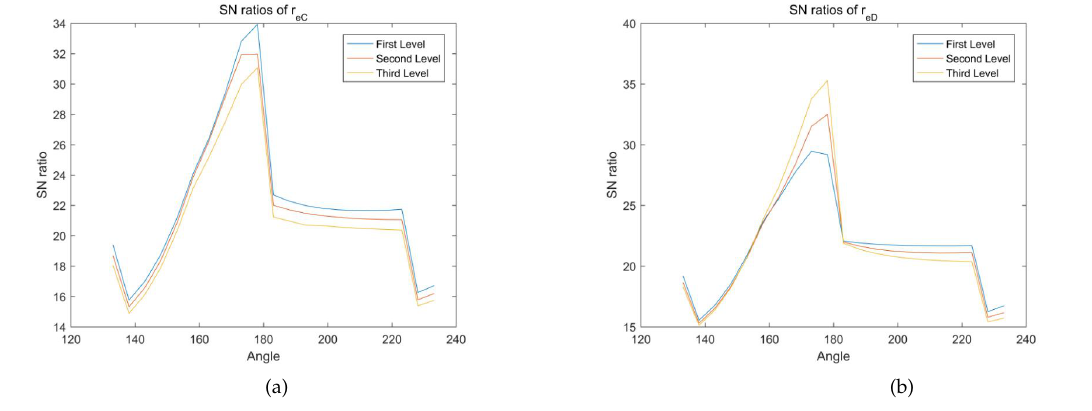
Figure 11. ( a ) The SN ratios of r eC ; ( b ) The SN ratios of r eD .